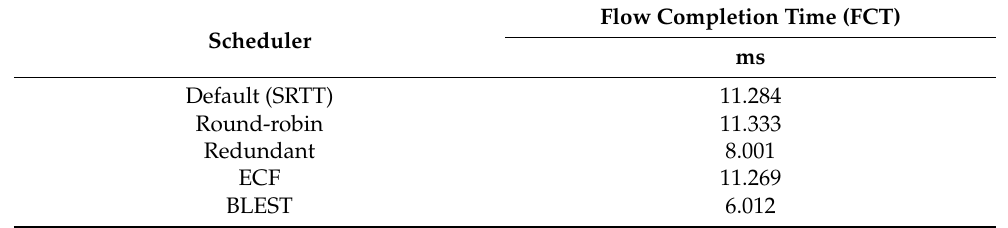
Table 4. Performance of the tested MPTCP schedulers in terms of FCT for BALIA as a CCA.